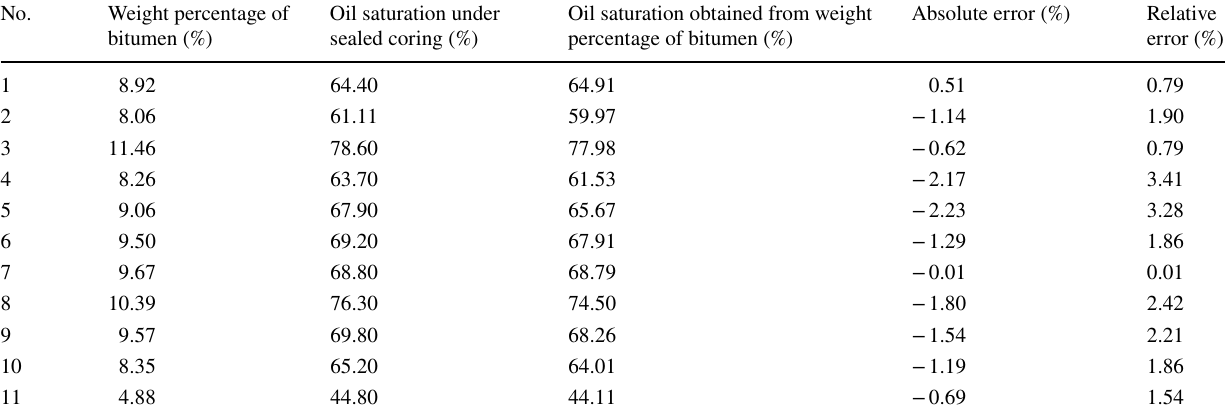
Table 2 Analysis results of weight percentage of bitumen and oil saturation under sealed coring in typical boreholes No.